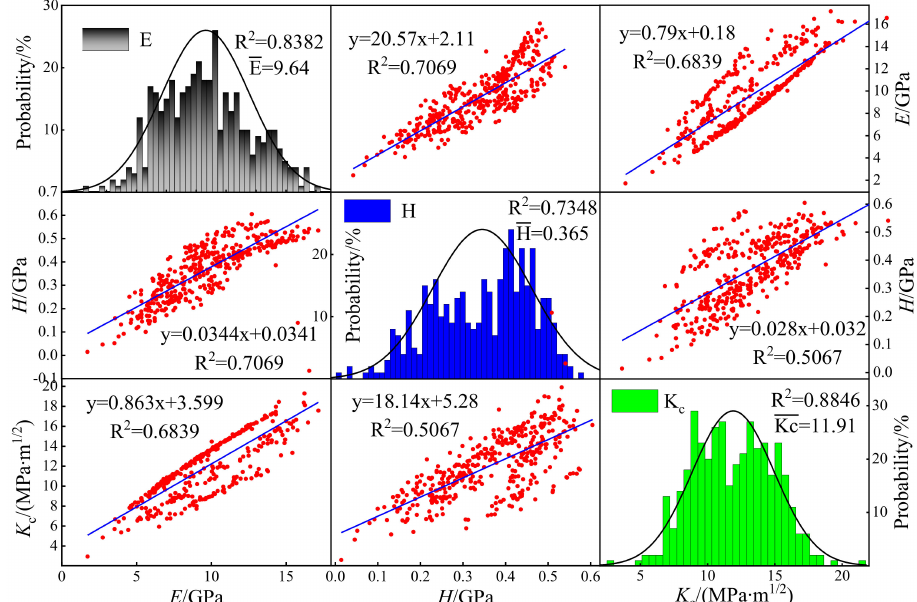
Figure 10. The correlation between H and K c was the lowest, and the correlation coefficient was 0.5067. In addition, the correlation coefficient between E and K c was 0.6839. It can be observed that data points present discrete distribution, which was probably caused by mineral heterogeneity, micro − cracks and micro − pores.